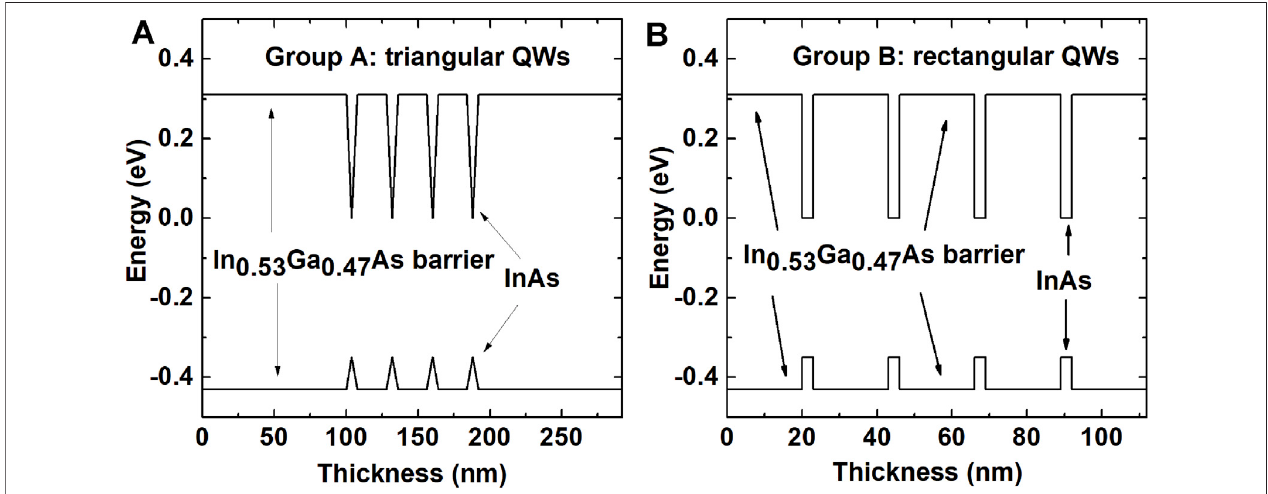
FIGURE 1 | Schematic energy-band diagrams of (A) group A lasers with triangular QWs and (B) group B lasers with rectangular QWs as active regions.